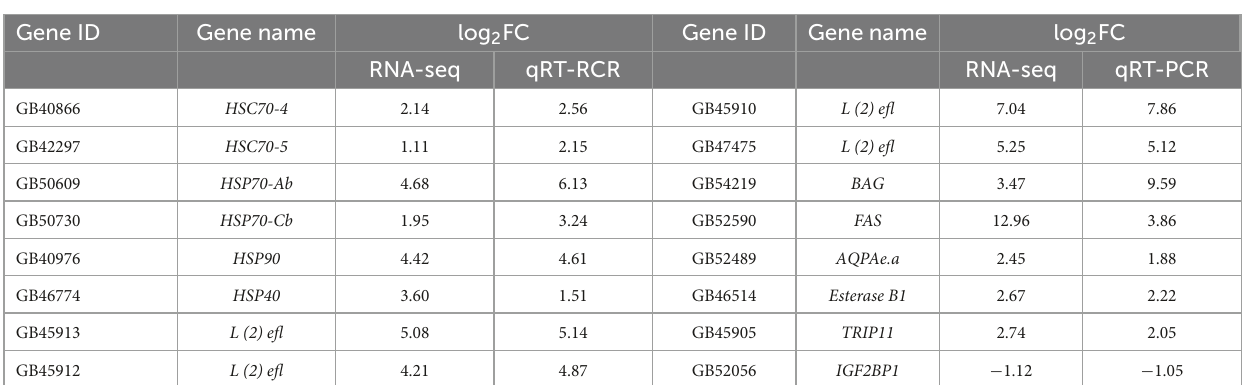
TABLE 3 Results of qRT-PCR and RNA-seq on